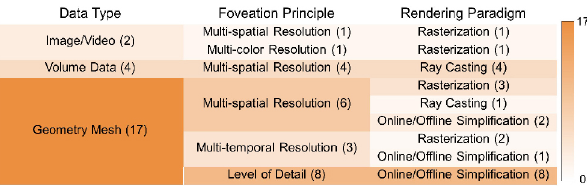
Fig. 6 Frequency of research in foveated rendering from 1990 to 2011. Numbers in parentheses indicate the number of studies using the specific data type, and foveated principle and rendering paradigm are listed in front of